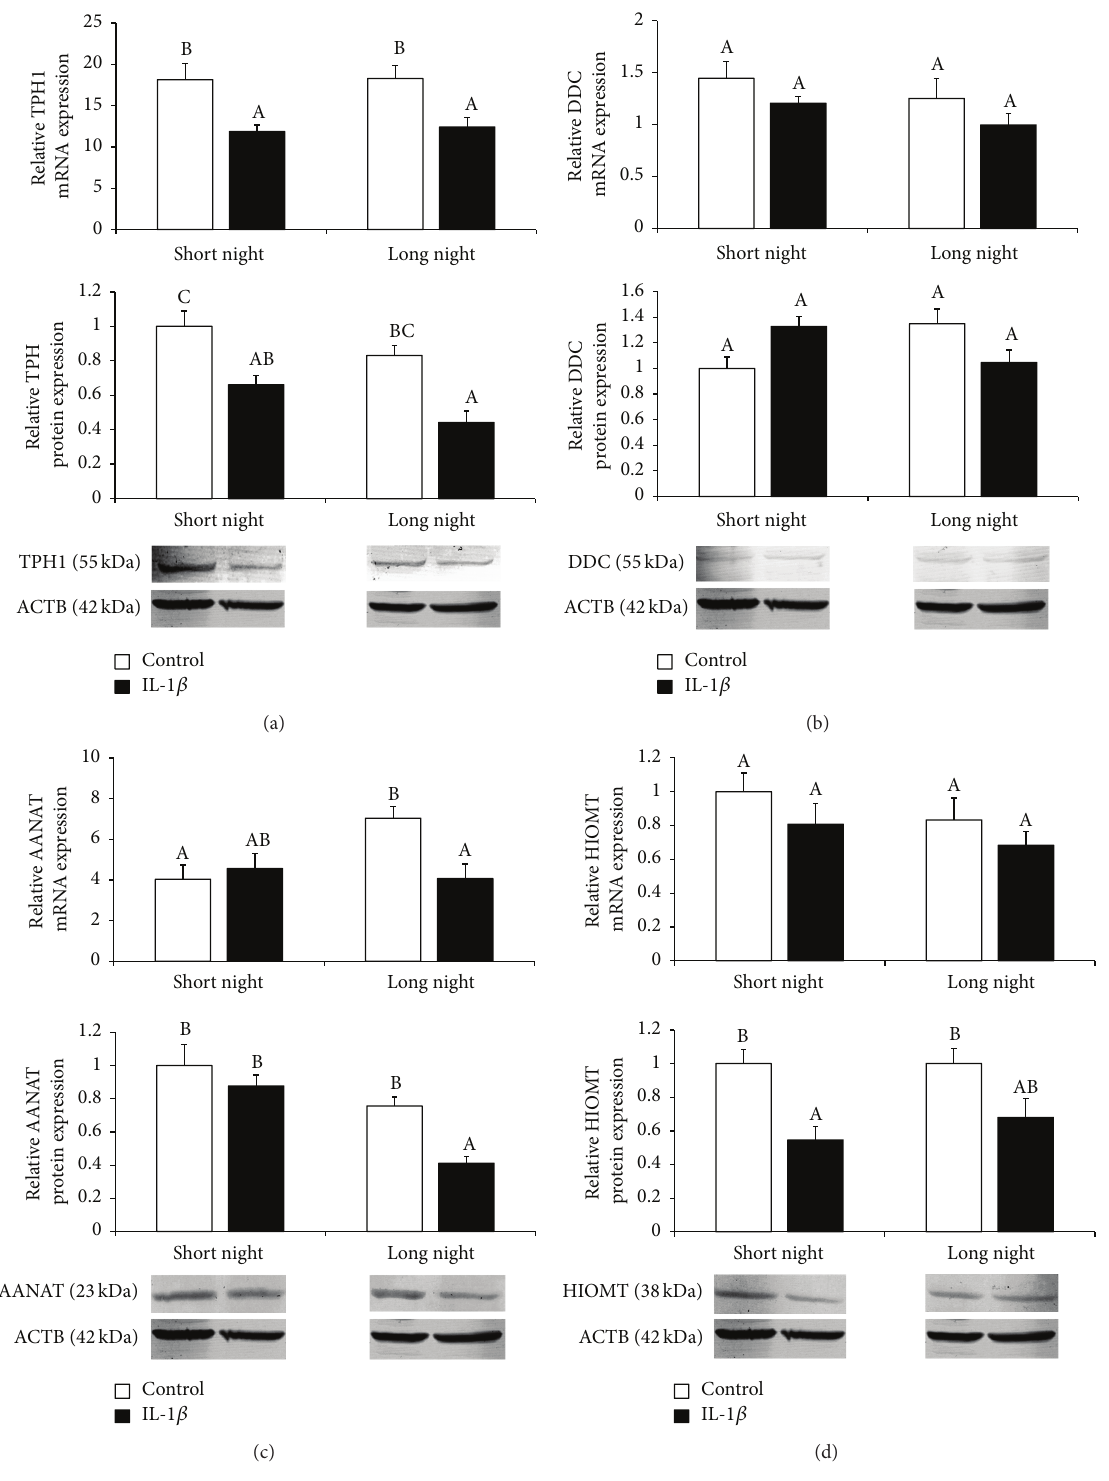
Figure 5: The effects of icv. injection of interleukin- (IL-) 1 𝛽 (50 𝜇 g/animal) or Ringer’s solution (50 𝜇 L) on the relative gene and protein expression (mean ± SEM; 𝑛 = 6 animals per group) of enzymes of the melatonin biosynthetic pathway (tryptophan hydroxylase 1 (TPH1, (a)); aromatic-L-amino-acid decarboxylase encoded by the dopa decarboxylase (DDC, (b)); arylalkylamine-N-acetyltransferase (AANAT, (c)); hydroxyindole-O-methyltransferase(HIOMT,(d)))inewesduringtheshortnight(SN,May/June)andlongnight(LN,November/December) photoperiods. All gene expression data presented in the figure were normalised to the average relative level of HIOMT gene expression in the control ewes from the SN photoperiod, which was set to 1.0. Protein expression data presented in a particular panel were normalised to the average relative level of protein expression in the control ewes from the SN photoperiod, which was set to 1.0. Different capital letters indicate significant ( 𝑃 < 0.05 ) differences according to a two-way ANOVA followed by Tukey’s post hoc